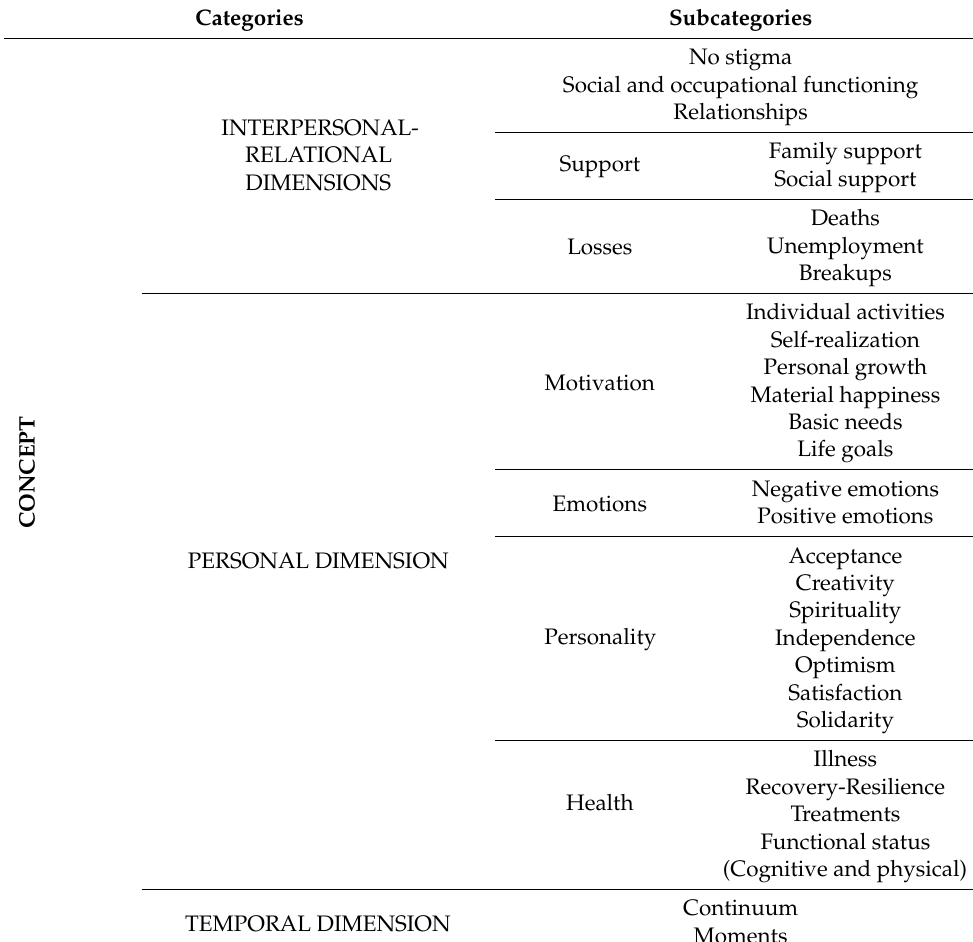
Table 3. Concept of happiness: categories and